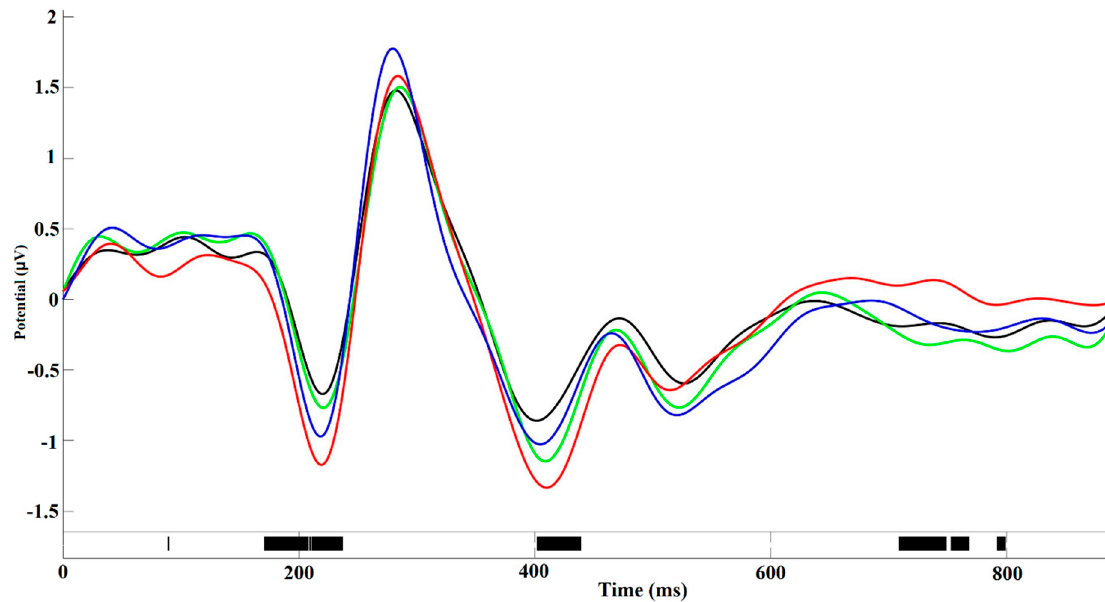
Figure 5. Amplitude–time ERP plot in medial frontal cortical area averaged across all assessments of one-self (red line), loved person (green line), neutral person (blue line) and unpleasant person (black line). The significant inter-object differences (permutation test) were revealed for the time intervals in about 150–250 ms, 400–450 ms, and 700–800 ms.